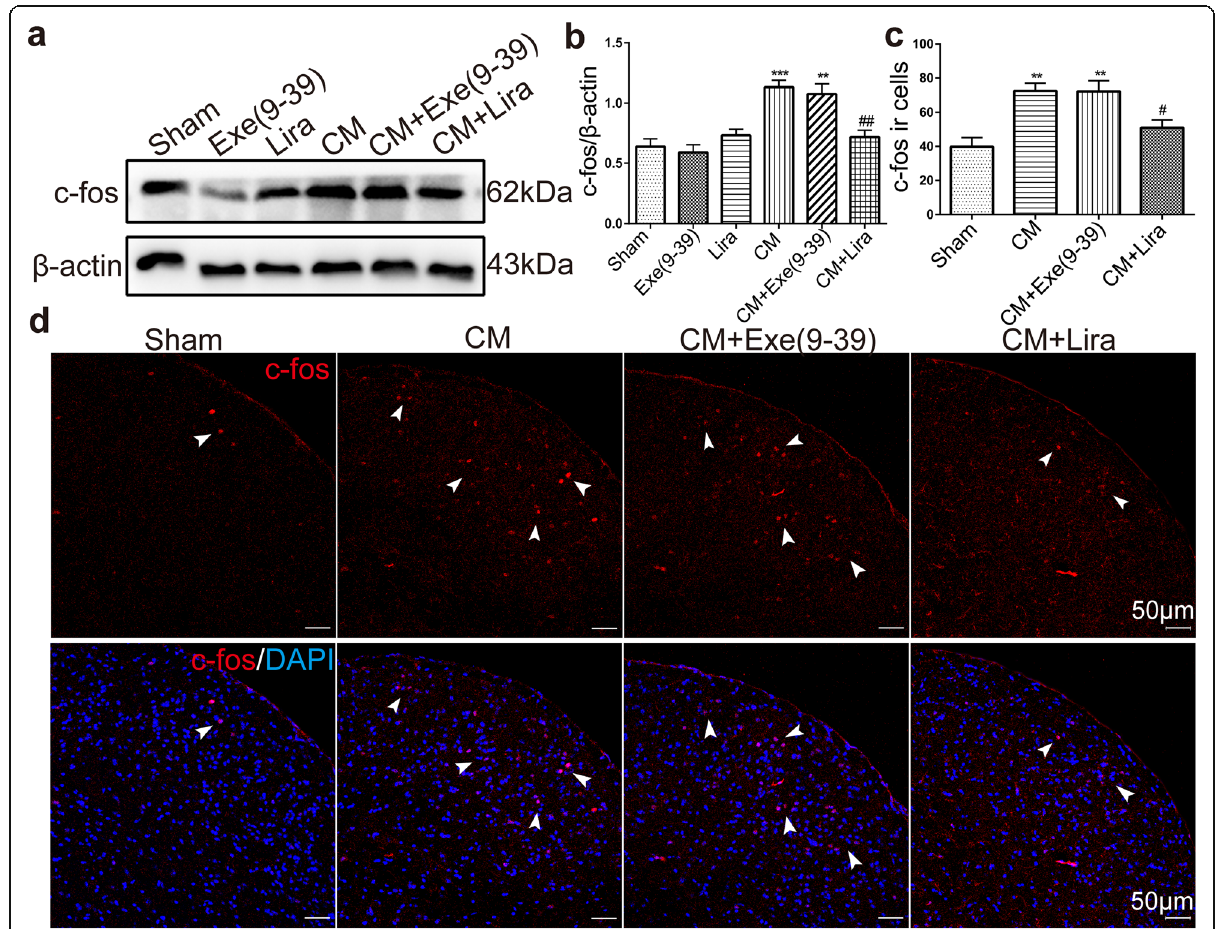
Fig. 5 Activation of GLP-1R reduced the c-fos protein level and the immunoreactive cells in the TNC in CM mice. a, b Western blots showing the changes in c-fos protein expression in the TNC following liraglutide and exendin(9 – 39) administration. The band intensities are presented as the percent (%) change relative to the sham group. Data are presented as mean ± SEM; n = 6/group; ** p < 0.01 and *** p < 0.001 vs. sham group; ## p < 0.01 vs. CM group. c, d Representative immunofluorescence images of c-fos in the TNC and the quantitative analysis of c-fos immunoreactive (ir) cells. Arrowheads indicate colocalization of c-fos-ir cells and DAPI. The results suggested that liraglutide reduced c-fos-ir cells in the TNC in CM mice. Data are presented as mean ± SEM; n = 4/group; six sections from each mouse; ** p < 0.01 vs. sham group; # p < 0.05 vs. CM group. Scale bars: 50 μ